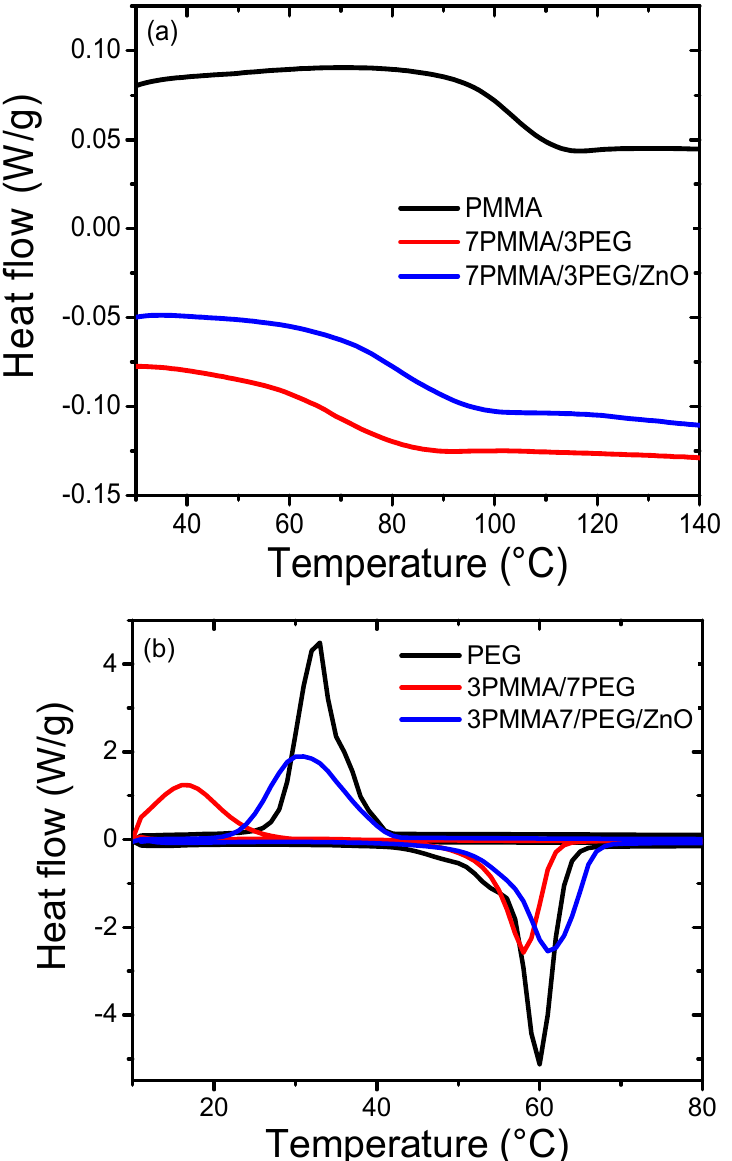
Figure 7. DSC curves for ( a ) neat PMMA, 7PMMA/3PEG and 7PMMA/3PEG/ZnO, and for ( b ) neat PEG, 3PMMA/7PEG and 3PMMA/7PEG/ZnO.